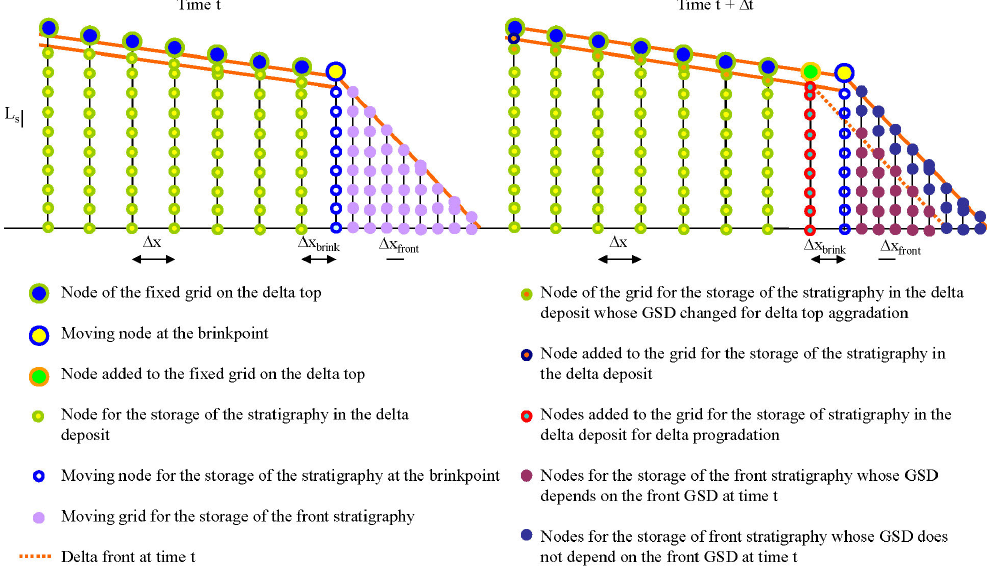
Figure 4. Model grids. GSD stands for grain size